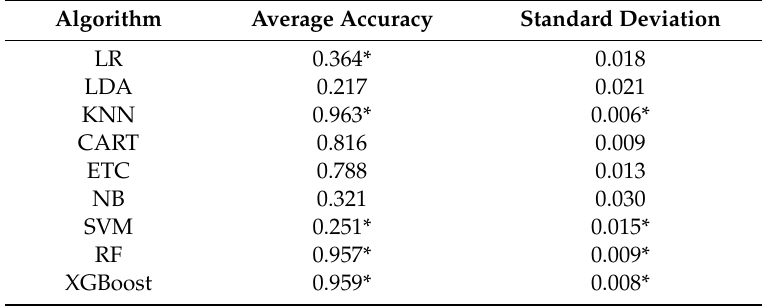
Table 11. Average accuracy—selected environmental and biometric data for user identification. With *: average accuracy defined considering the tuning of hyperparameters.